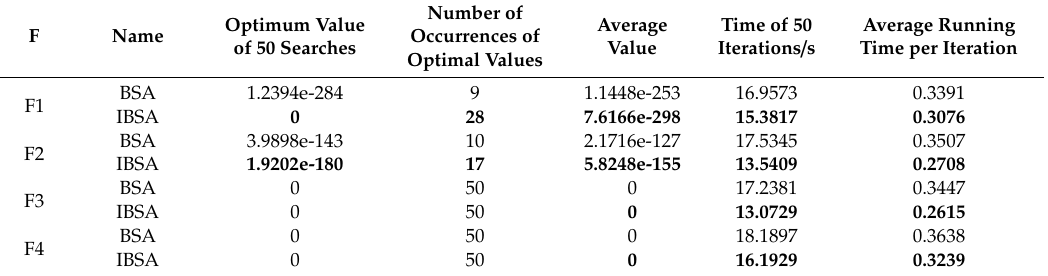
Table 2. Optimization